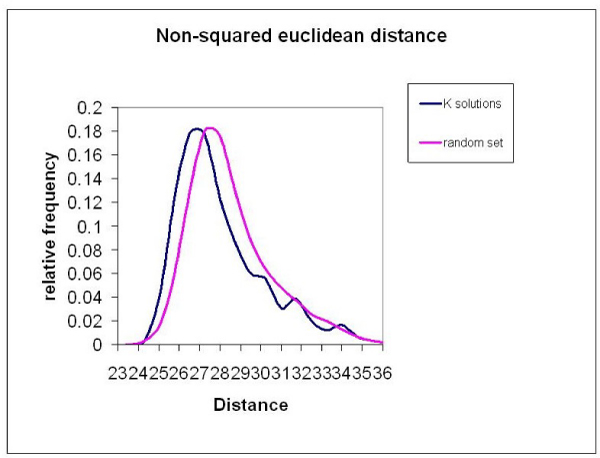
Proximity matrix of solutions. Normalized frequency histogram of the elements of the proximity matrix built by computing the non-squared Euclidean distance ||log10 Ki, log10 Kj||i, j = 1...n, where {Ki} and {Kj} represent single solution parameter sets and n is the number of unknown model parameters. On the abscissa the distance values. For comparison we show also the distribution of the proximity matrix for a large set of randomly generated K vectors.